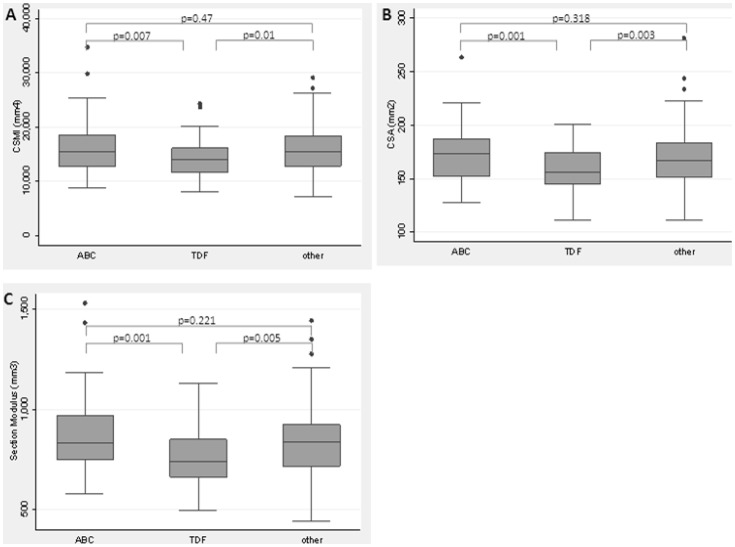
Hip structural parameters at baseline by type of NRTI at study entry (A) CSMI (bone's ability to resist bending), (B) CSA (bone's ability to resist axial compressive force) and (C) section modulus (bending strength).Abbreviations: CSA, cross-sectional area; CSMI, cross-sectional moment of inertia.